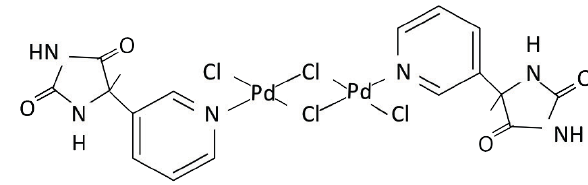
Figure 8 Binuclear pyrazolate square-planar palladium